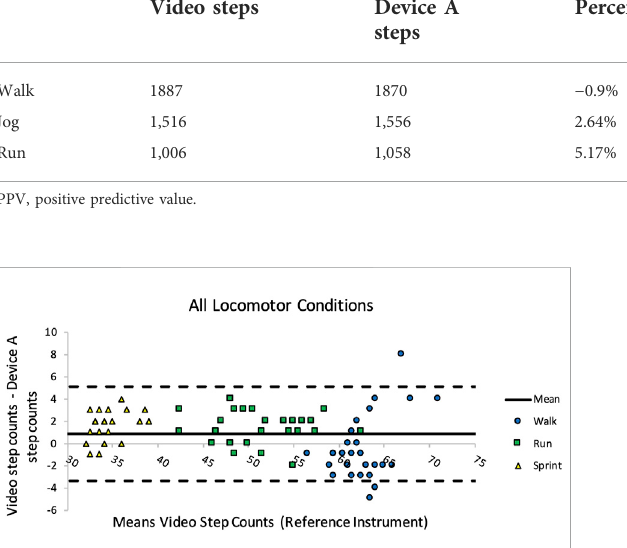
FIGURE 3 Bland-Altmanplotdemonstratingthedifferencebetweenthe Bioharness ™ and visual step count. *The number of steps taken changes as a result of changes in each locomotor condition velocity. *The solid line is the mean, while the dashed lines represent the repeatability coef fi cient (±1.96